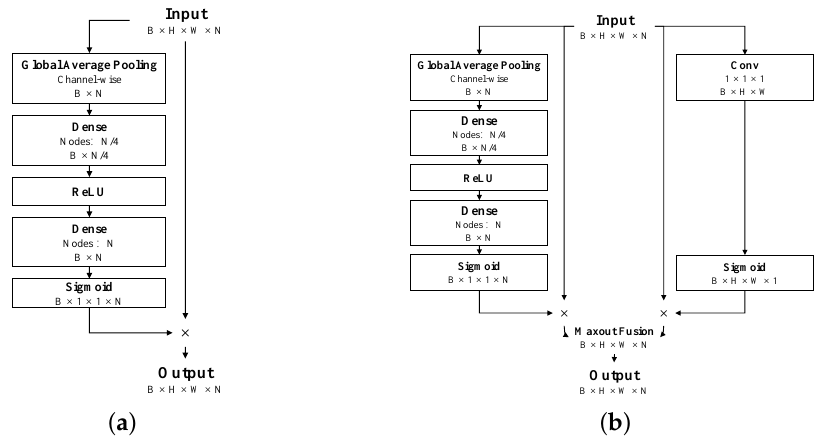
Figure 2. SE block and scSE block. ( a ) SE block; ( b ) scSE block.